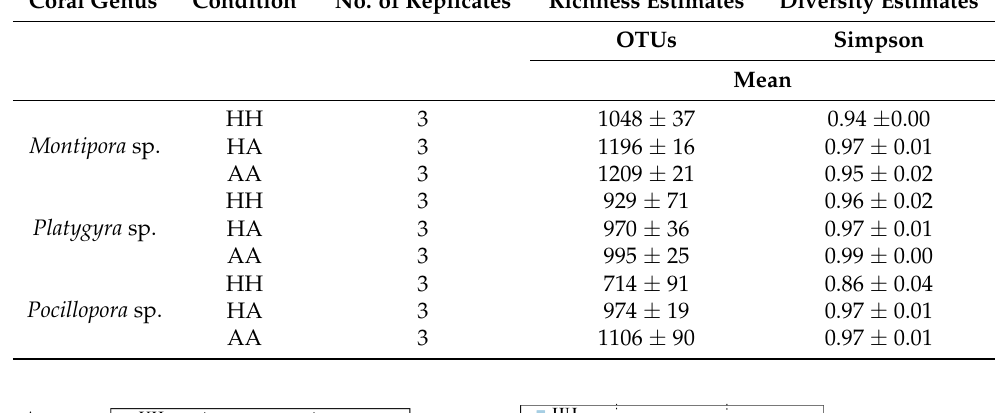
Table 1. Richness and Diversity estimates of bacterial 16S rRNA sequencing data of coral samples. HH: the non-algae part; HA: the junction of the non-algae part and the algae part; AA: the algae part.